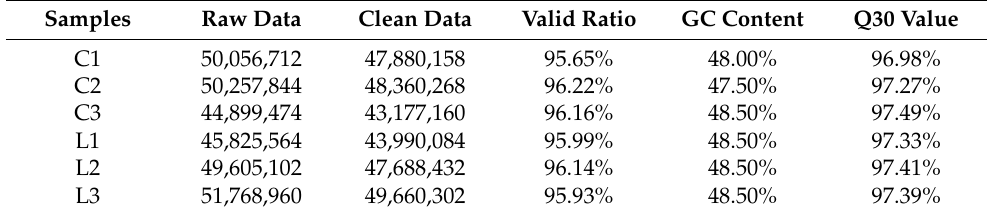
Table 1. Quality analysis of transcriptome